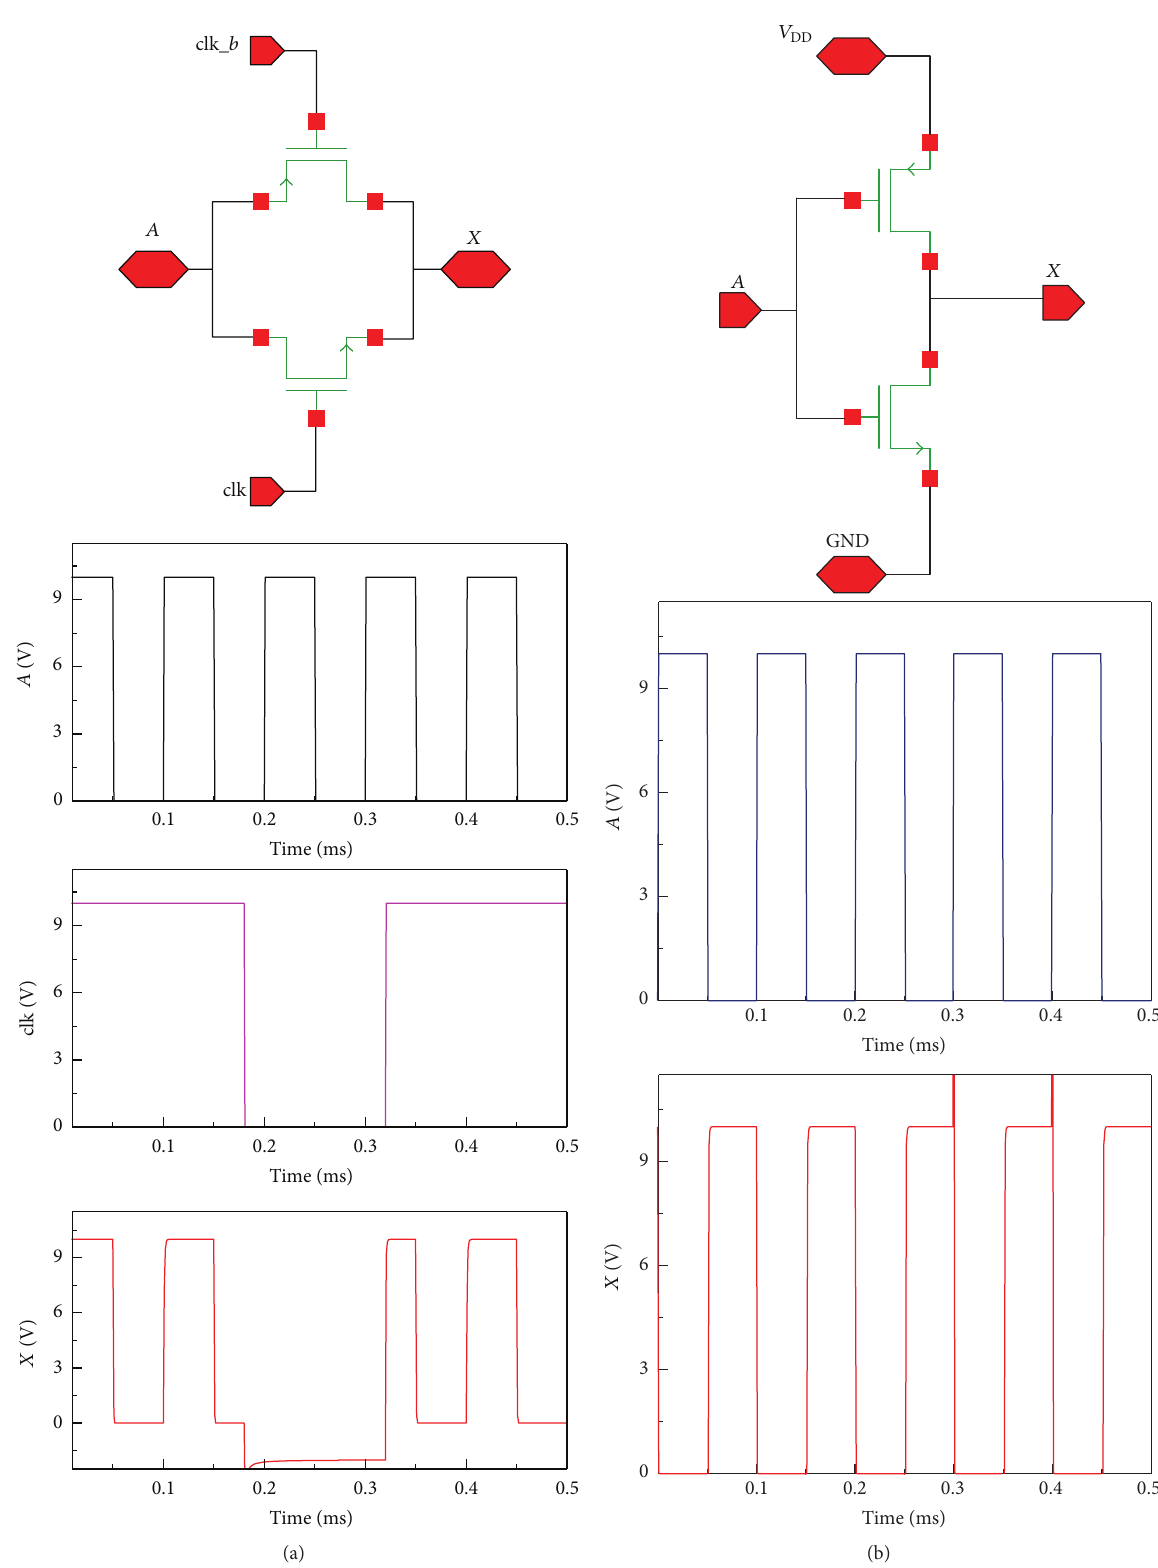
Figure 5: Schematics (top) and waveforms (bottom) of (a) transmission gate and (b)